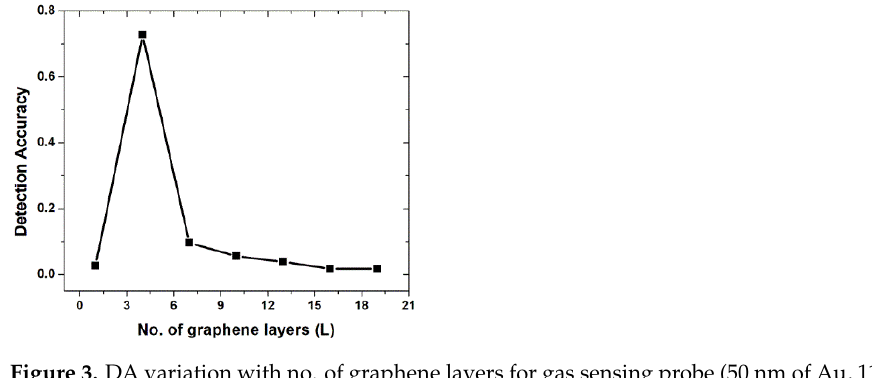
Figure 3. DA variation with no. of graphene layers for gas sensing probe (50 nm of Au, 11 nm silicon) for gaseous medium refractive index 1 RIU. The square symbols are simulated data points, which are fitted with black line.